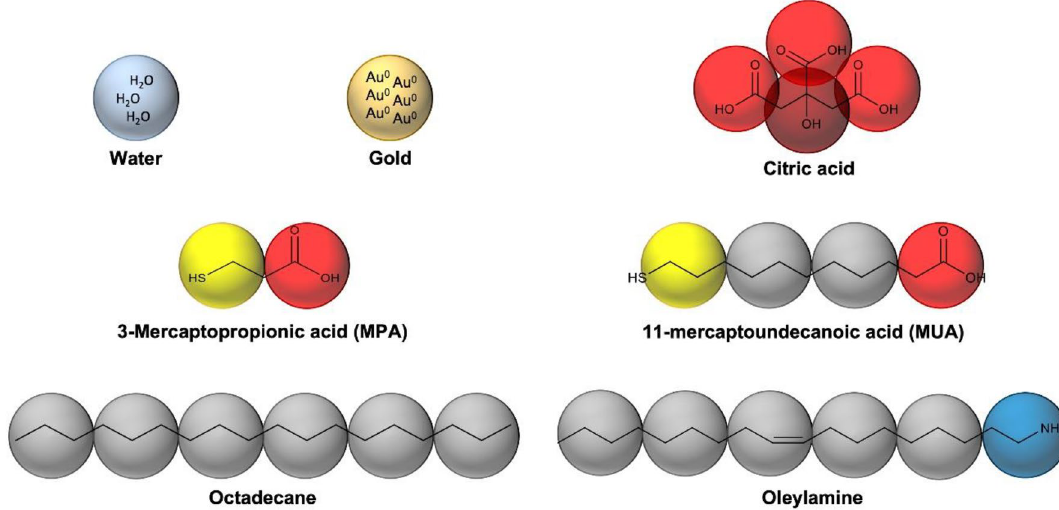
Figure 6. Mesomolecular model: the coarse-grained applied for all components is represented with different types of beads. Water (W-type) and gold beads (Au-type) are depicted in light blue and yellow, respectively. Both contain three gold atoms or water molecules. Water as solvent and gold as AuNP are formed by large number of individual beads. Five kinds of surfactants with different length and bead types are used. Citrate anion is formed by two different beads, three terminal anion-like fragments (O-type) and a central alcohol group (OH-type), depicted in light and dark red, respectively. Both MPA (S-type short) and MUA (S-type long) contain a terminal thiol group depicted in light yellow (S-type), and a hydrophilic anion fragment (O-type), depicted in red. Furthermore, MUA’s chain needs to use hydrocarbon beads (C-type), depicted in light grey. Oleylamine also contain two different types of beads, a head group formed by an amine group (N-type), depicted in dark blue, and five tail beads of C-type (hydrocarbon beads). The octadecane is conformed by six equal beads of